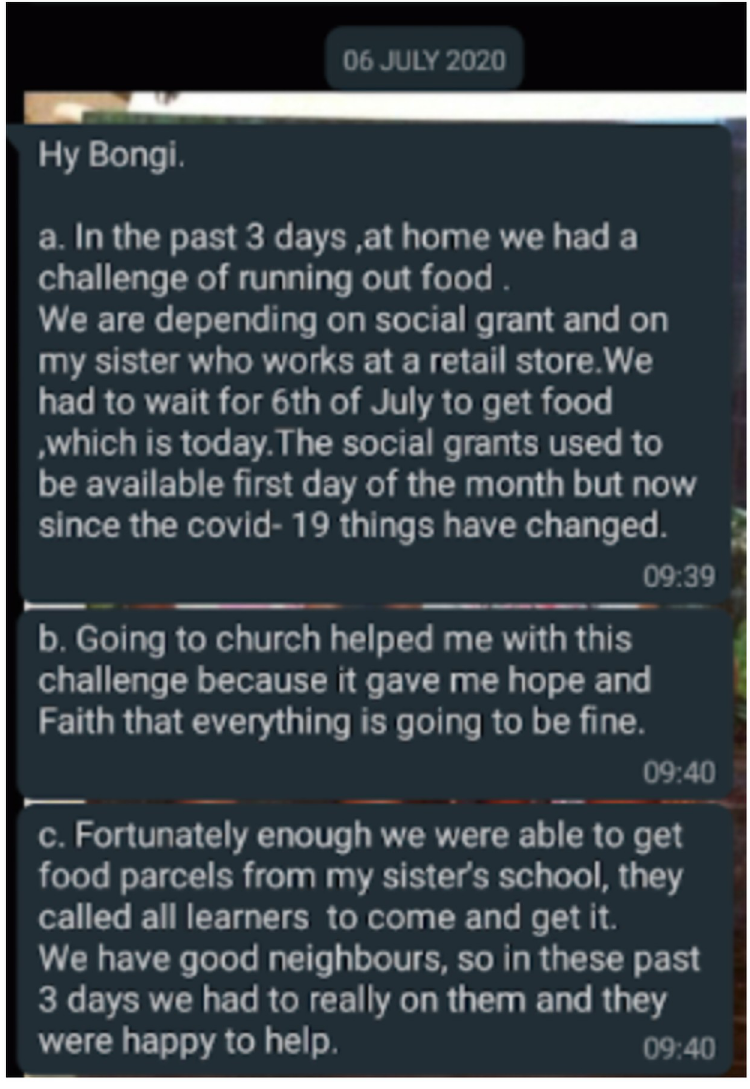
Fig 5. Busisiwe’s W1 digital diary